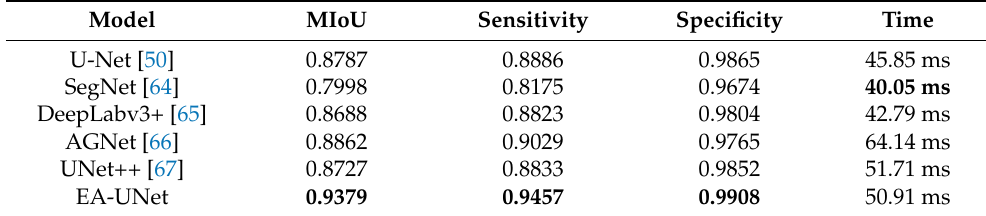
Table 3. Performance comparison between EA-UNet and other